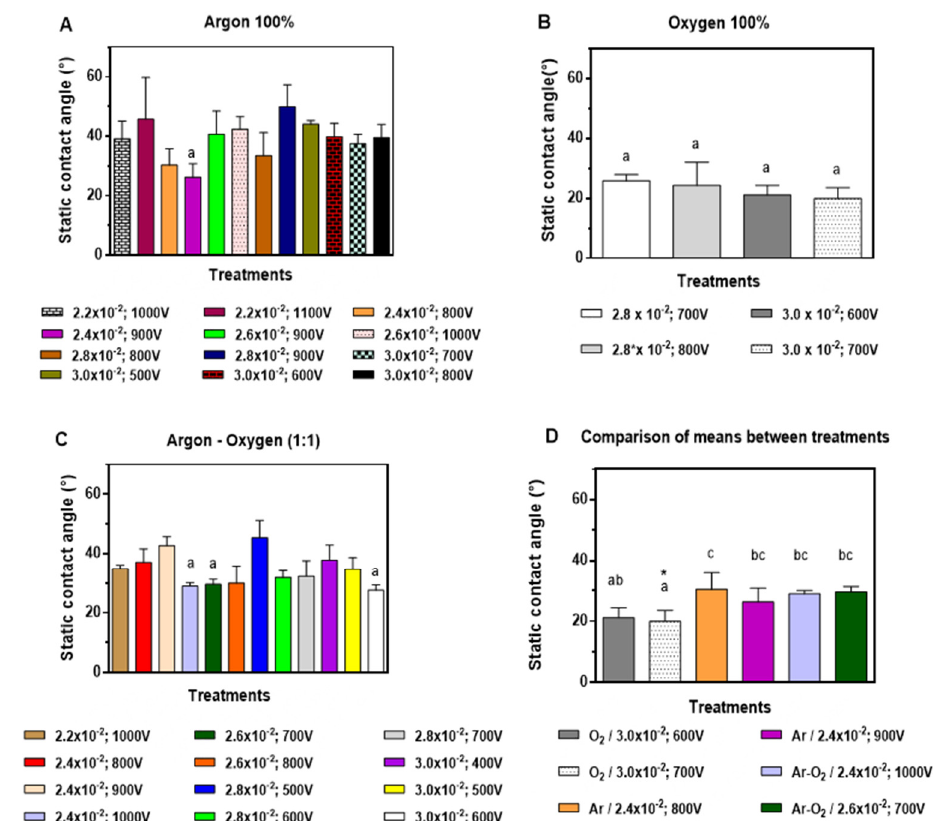
Figure 1. Static contact angle ( ◦ ) of low-density polyethylene (LDPE sheets) exposed to: ( A ) 100% argon ( v / v ); ( B ) 100% oxygen ( v / v ), ( C ) 50:50% argon and oxygen ( v / v ). ( D ) Best treatments (mean ± SD, n = 5). Letters correspond to heterogeneous groups obtained by Tukey post hoc test, where letter a corresponds to the best treatment, followed by letters ab and bc. * is to higlight the best treatment.